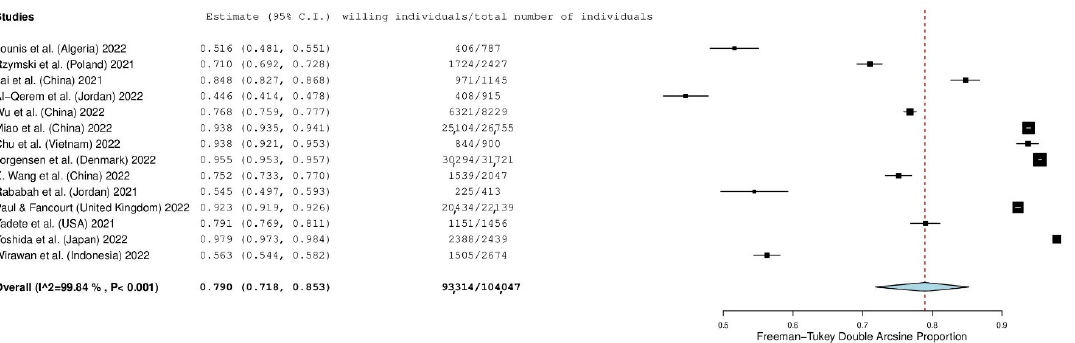
Figure 2. Forest plot of individuals’ willingness to accept a first COVID-19 booster dose. The size of black squares denotes the sample size, while the horizontal line through the square denotes the 95% confidence interval for the willingness proportion.